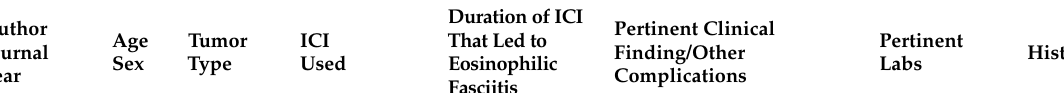
Table 4. Cases of eosinophilic fasciitis in the setting of immune checkpoint inhibitors